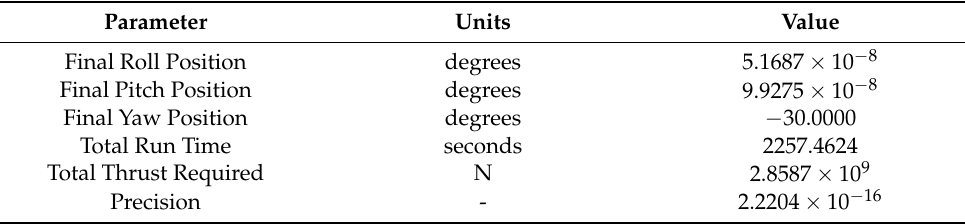
Figure 5. The control measured in terms of thrust applied, which can be estimated for fuel consump- tion, for a de-orbiting spacecraft using the sinusoidal autonomous trajectory in LEO for roll (yellow), pitch (pink), and yaw (blue). Table 4. Simulation results of the sinusoidal